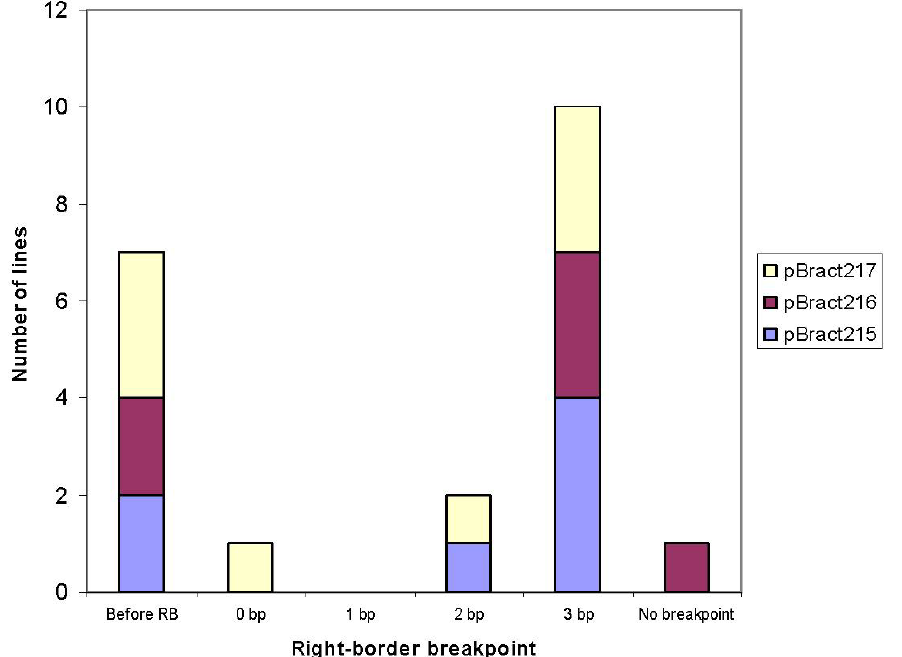
* Right border breakpoint is defined as the number of sequential bases incorporated into the plant genome after the start of the right-border repeat region. A negative value indicates truncation of the T-DNA. Figure 2. Right-border T-DNA breakpoints identified during junction-sequence analysis. The different colours correspond to the different constructs that the lines were transformed